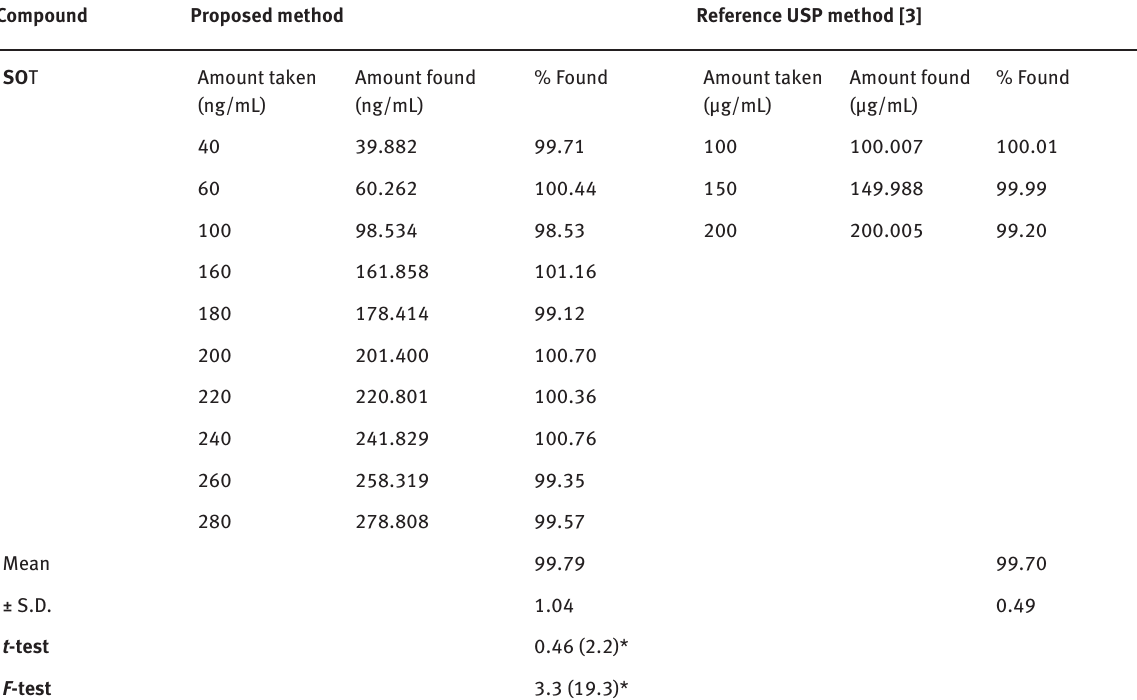
Table 2: Assay results for the determination of SOT in pure form by the proposed method and the reference USP method.